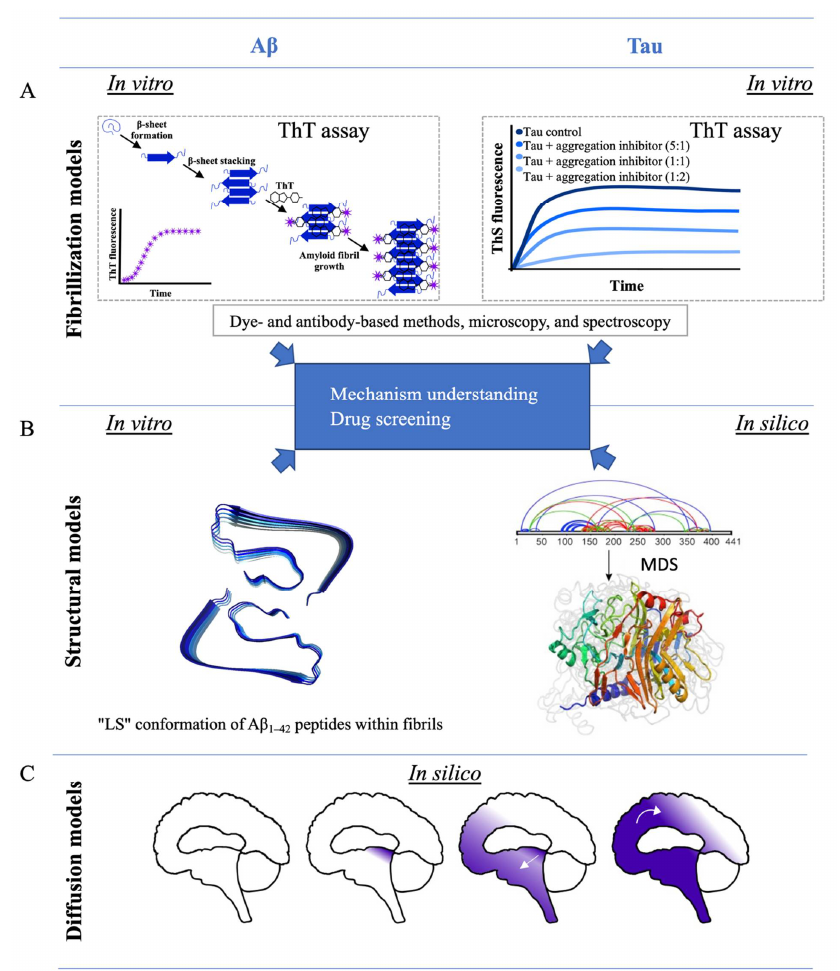
Figure 2. Cell-free in vitro and in silico models of Aβ peptides and tau proteins. (A) Fibrillization models of Aβ peptides and tau proteins based on ThT assays. (B) Structural models of Aβ 1–42 peptides and 441-residue tau protein by Gremer et al. (2017) [57] and Popov et al. (2019) [58] (License number 5107120599622, Jul 13 2021), respectively. (C) Models of protein diffusion of Aβ peptides and tau proteins in the brain developed by Weickenmeier et al. (2018) [59] and Yang et al. (2019) [60]. Abbreviations . ThT: Thioflavin T; MDS: molecular dynamic simulations.